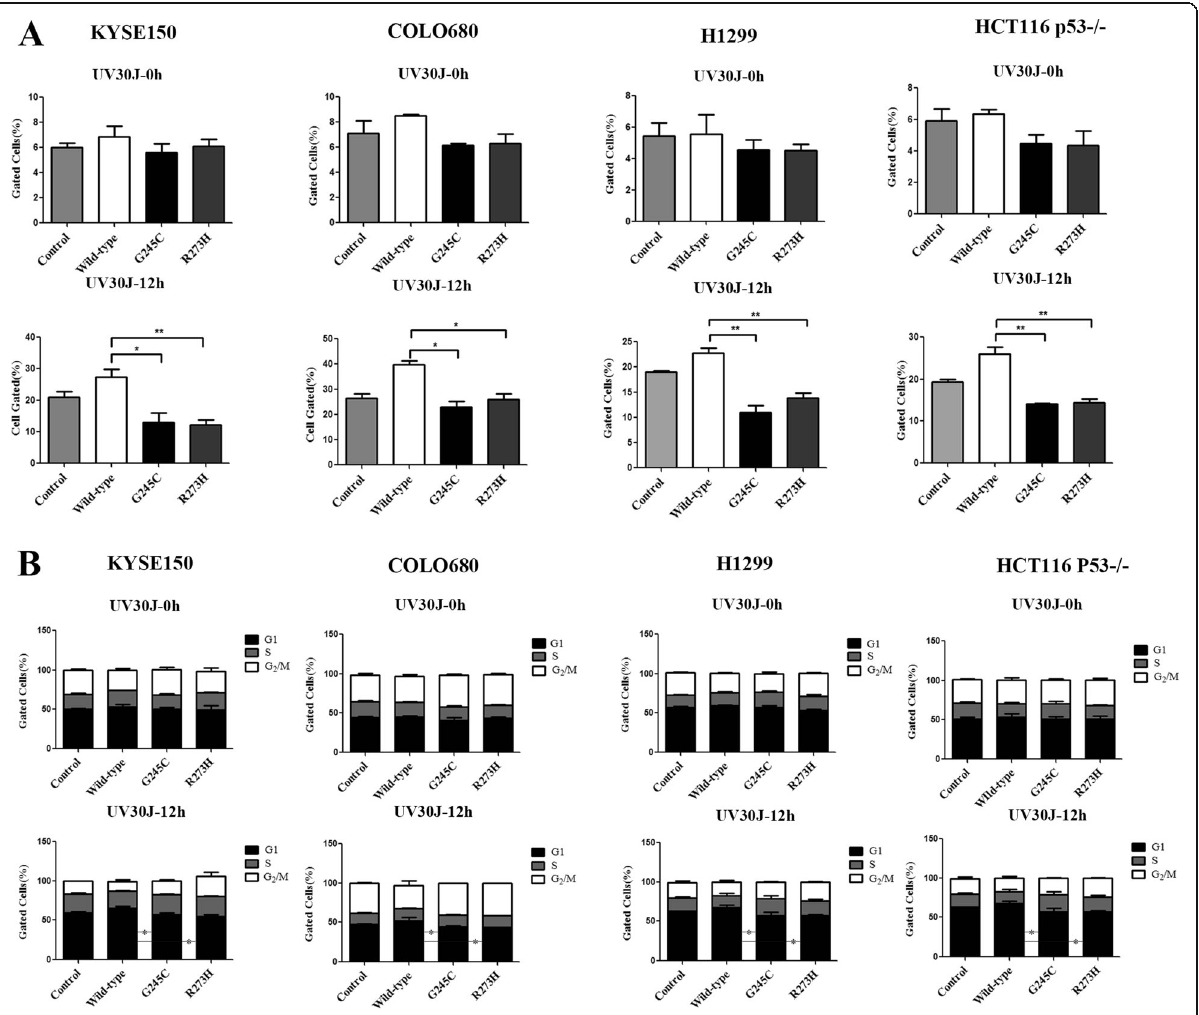
Fig. 4 G245C and R273H conferred cells stronger resistance to UV-induced apoptosis and attenuated cell cycle arrest. a Apoptosis degree induced by UV 30 J for 0 h and 12 h in cell lines. The data were presented as the portion of cells undergoing apoptosis tested by flow cytometry, the cells were dyed by PI and AnnexinV. b Quantitation of cell cycle arrest ratio in cells transfected by WT and mutant TP53 plasmids after UV 30 J for 0 h and 12 h treatment. Data was shown as the percentage of DNA amounts dyed by PI which was detected by flow cytometry. Data was shown as mean ± SE. (* P < 0.05, ** P < 0.01, *** P <